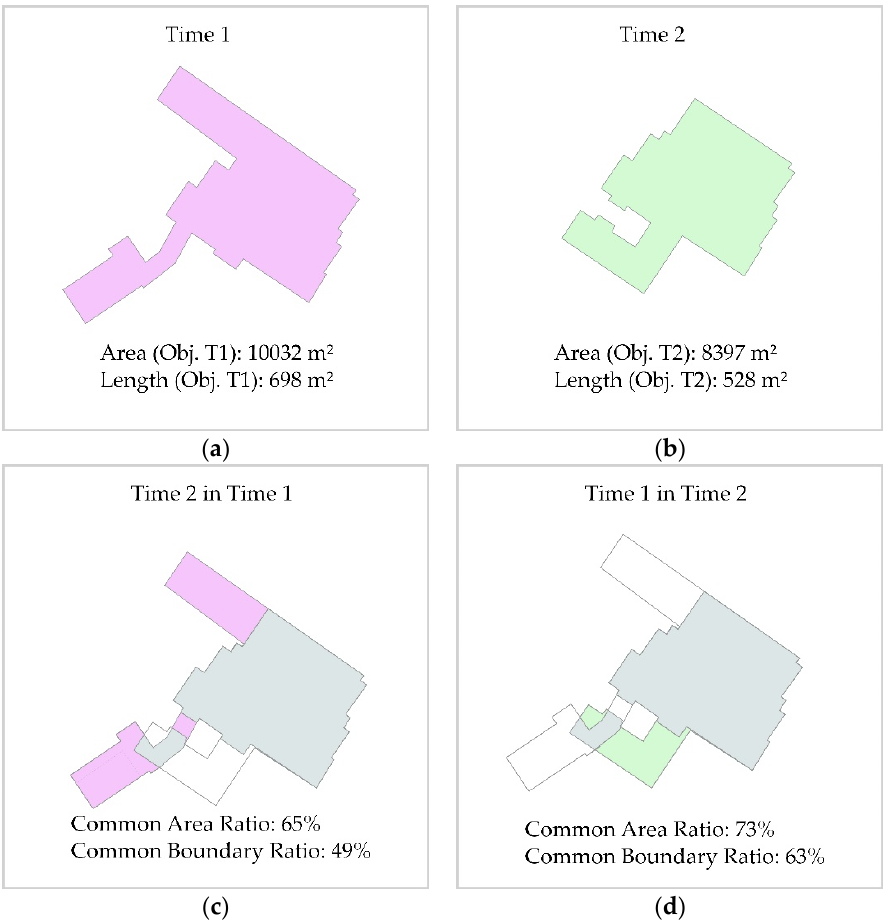
Figure 3. Examples of Common Area Ratio ( CAR ) and Common Boundary Ratio ( CBR ) for two foot- prints from different time points: ( a ) building at time 1; ( b ) building at time 2; ( c ) CAR and CBR of T1, T2; ( d ) CAR and CBR of T2, T1. Violet indicates the old area, green is the new area, and gray is the overlapping area.